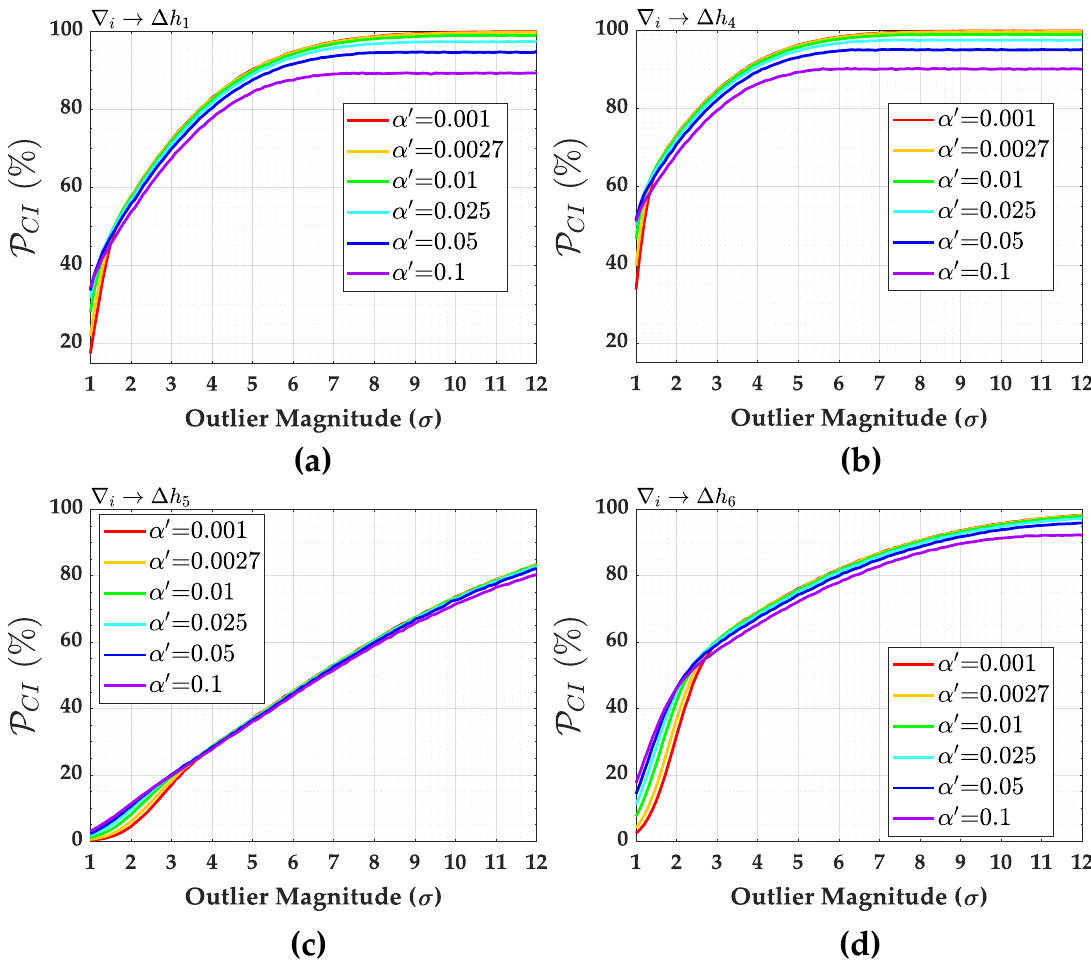
Figure 15. Probability of correct identification ( P CI ) for network ( b ). ( a ) P CI for ∆ h 1 . ( b ) P CI for ∆ h 4 . ( c ) P CI for ∆ h 5 . ( d ) P CI for ∆ h 6